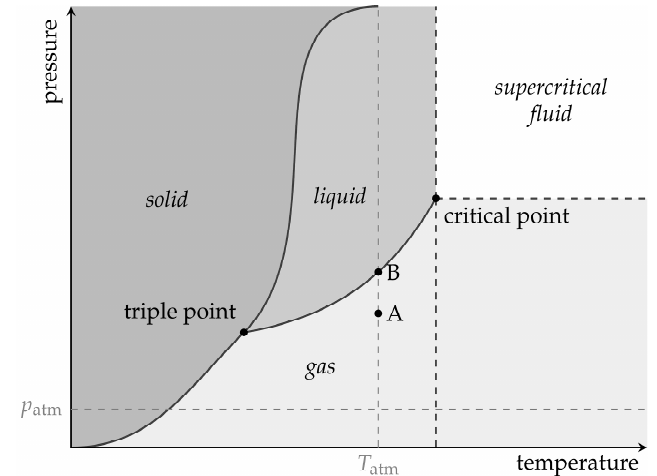
Figure 1. Phase diagram with exemplary storage conditions of compressed gas (A) and liquefied gas (B), based on [27].